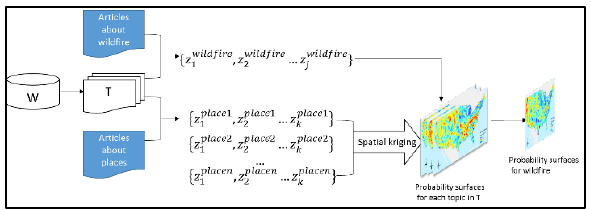
Figure 1. Computational framework for detecting spatial wildfire dynamics